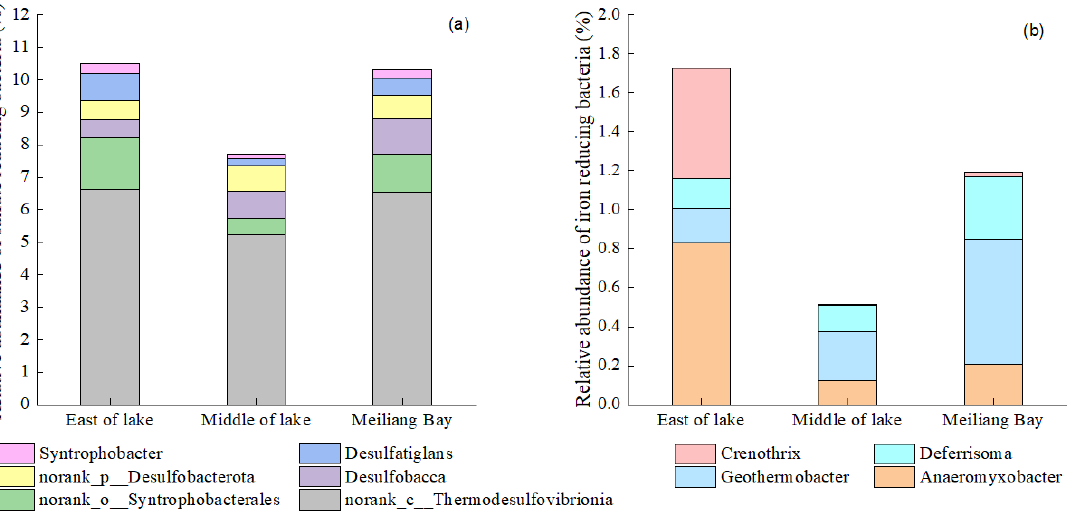
Figure 6. ( a , b ) Genus-level classification of typical sulfate reducing bacteria and iron reducing bacteria in surface sediments of Taihu Lake.